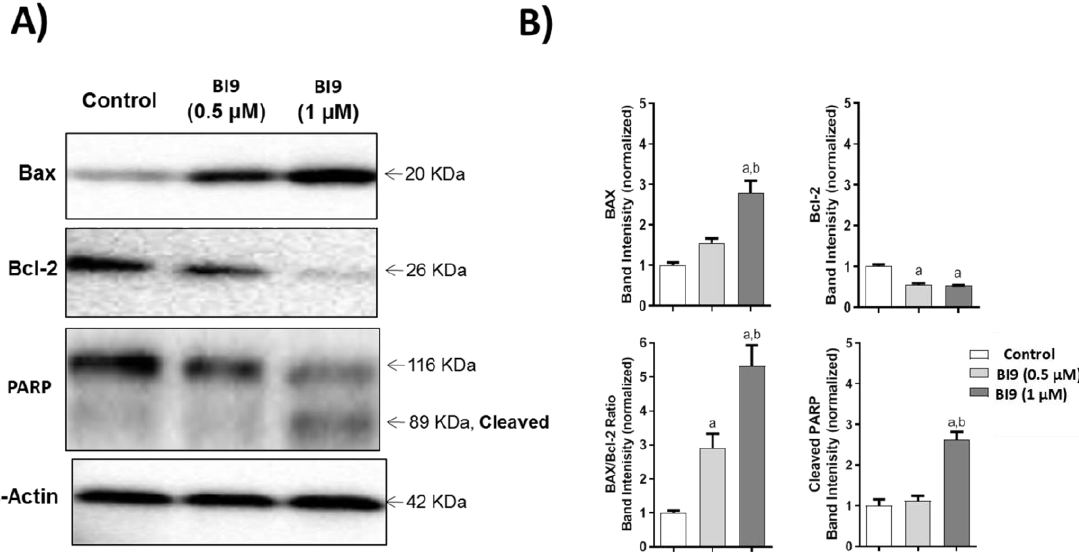
Figure 4. The immunoblotting of BAX, Bcl-2, and cleaved PARP (All were normalized to β -actin). ( A ) Representative western blots images show the effect of compound BI9 at 0.5 µ M and 1 µ M concentrations on the expression levels of BAX, Bcl-2, and cleaved PARP proteins in HL-60 leukemia cells. ( B ) Quantification of the tested proteins in HL-60 leukemia cell lysates, both normalized the β -actin, as a protein internal control. The control group was set to ‘1’, and all data from three separate experiments are shown as mean ± SEM. a and b indicate statistically significant differences from the control and BI9 (0.5 µ M) group, respectively at p < 0.05, in one-way ANOVA with Tukey’s multiple comparisons test.